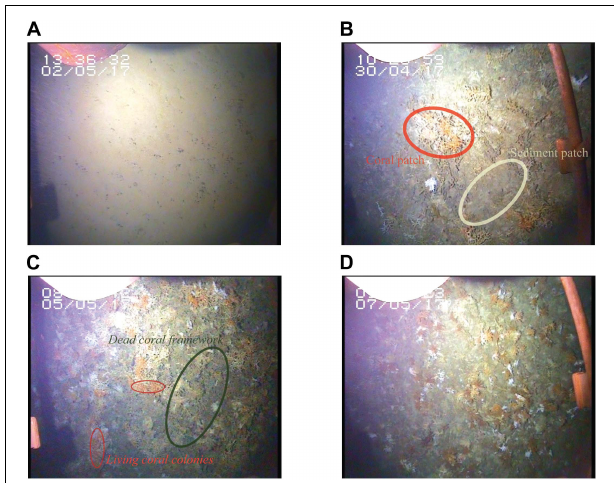
FIGURE 4 | Stills extracted from the video that was mounted on the boxcore displaying the four habitats sampled by box core. (A) Reference site on Rockall Bank, (B) the summit of Haas mound, note the patchy distribution of coral framework and sediment and (C,D) southern flank of Haas and Oreo mound, respectively, showing a thick layer of living coral and dead coral